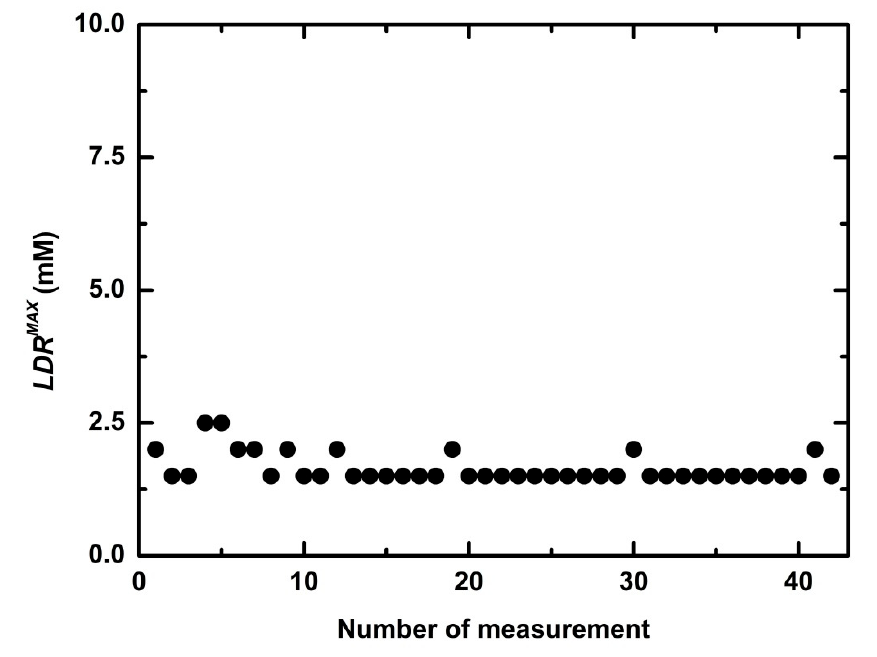
Figure 8. Maxima of linear dynamic range of the optical sensitive layer in 42 repeated measurements during two months.